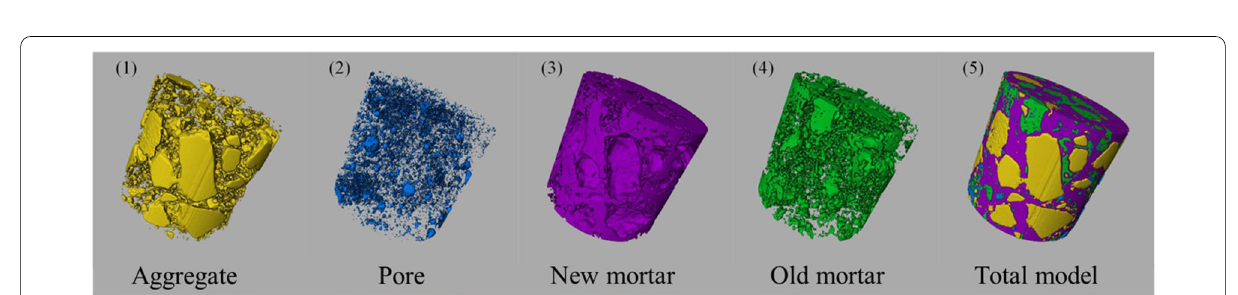
Fig. 5 Reconstruction of 3D model for RAC